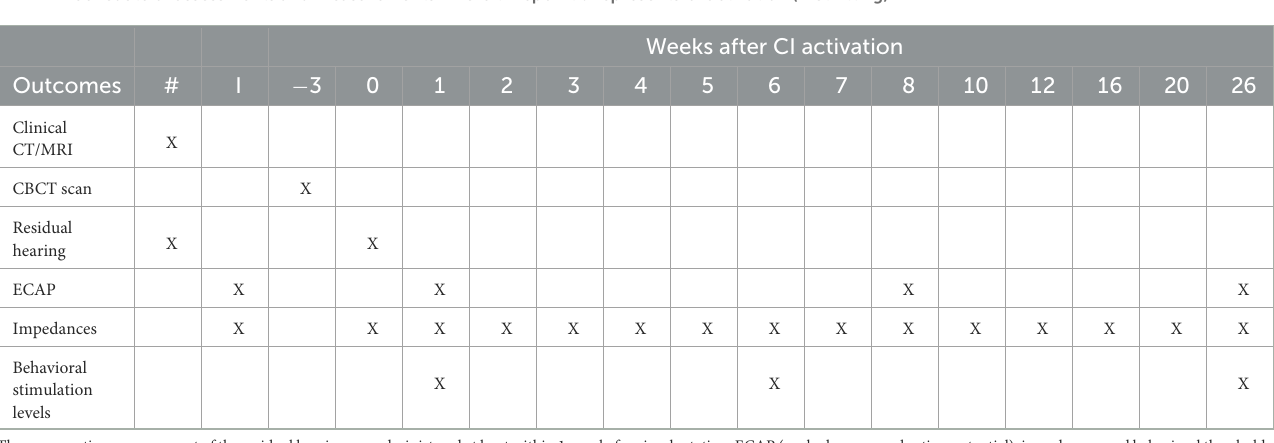
TABLE 2 Schedule of assessments and measurements where timepoint 0 represents CI activation (first